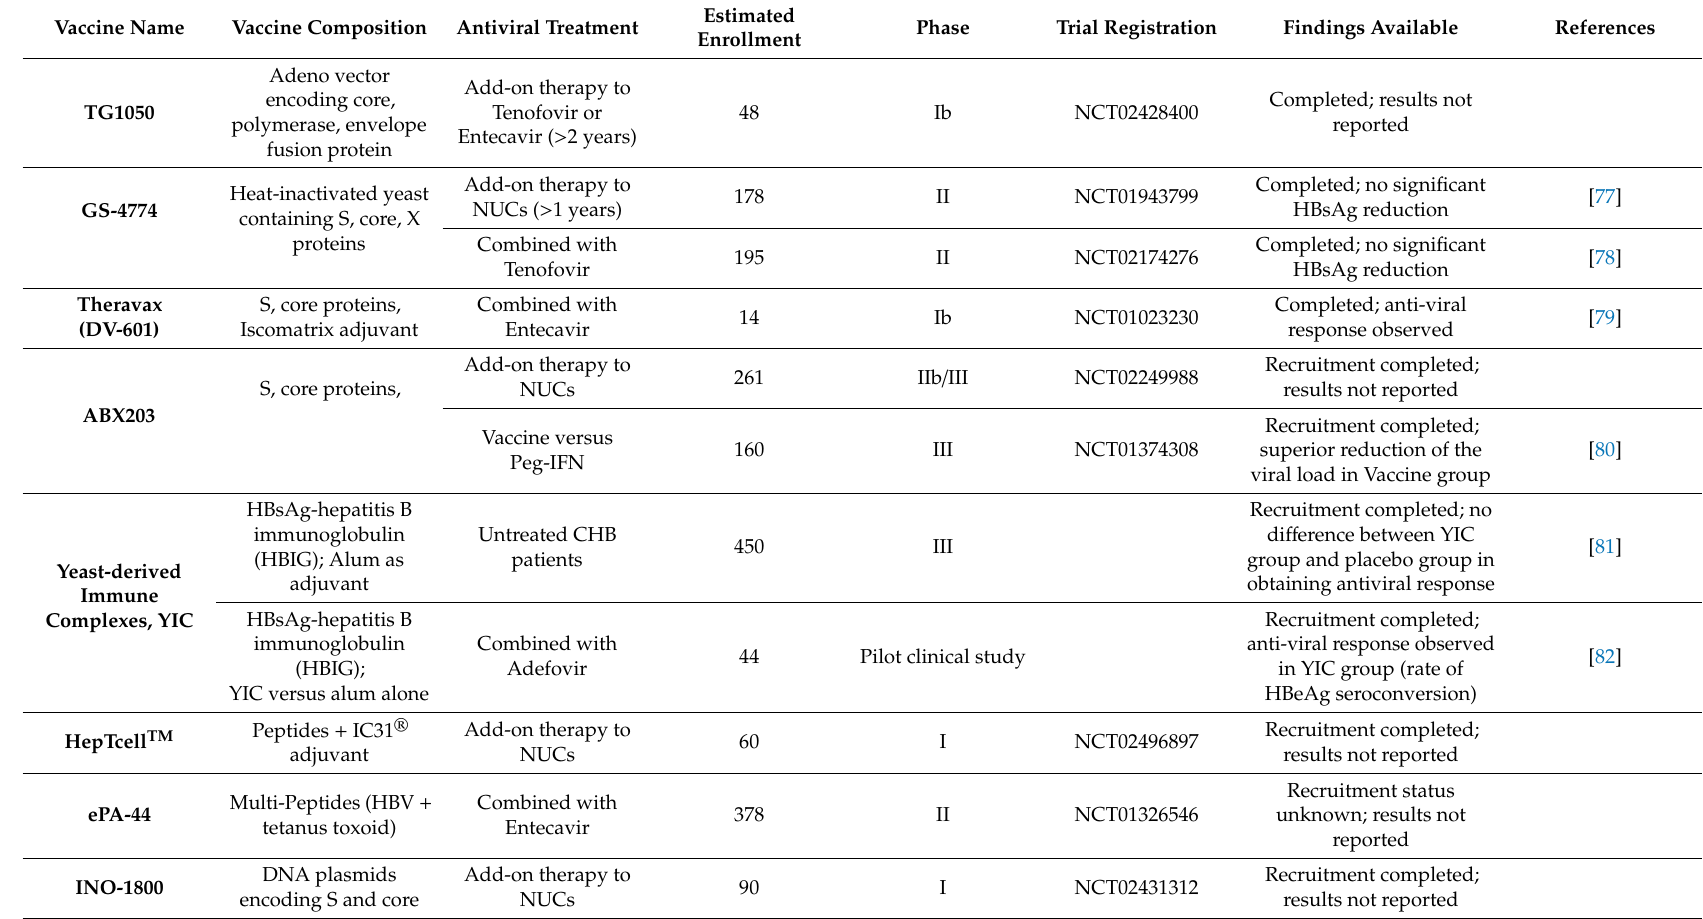
Table 1. Therapeutic Hepatitis B vaccines in clinical